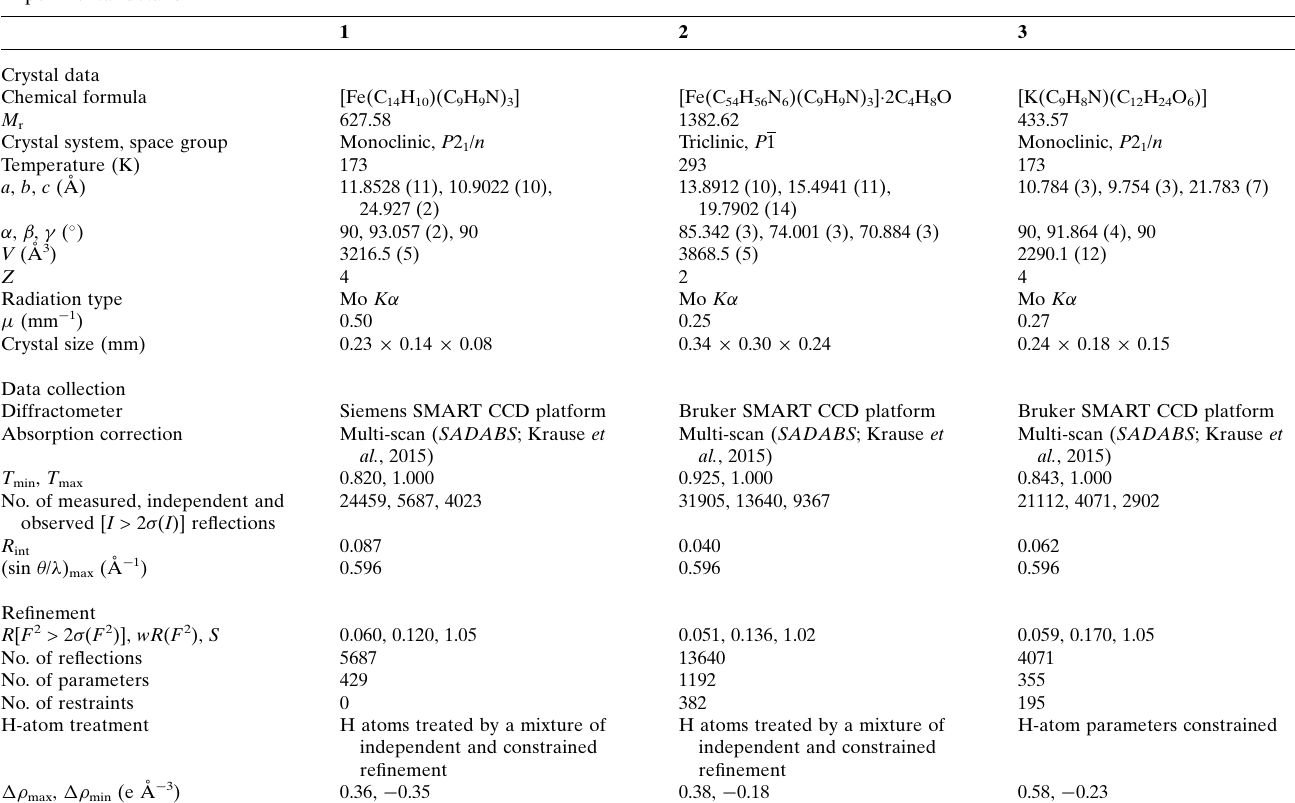
Table 5 Experimental details.